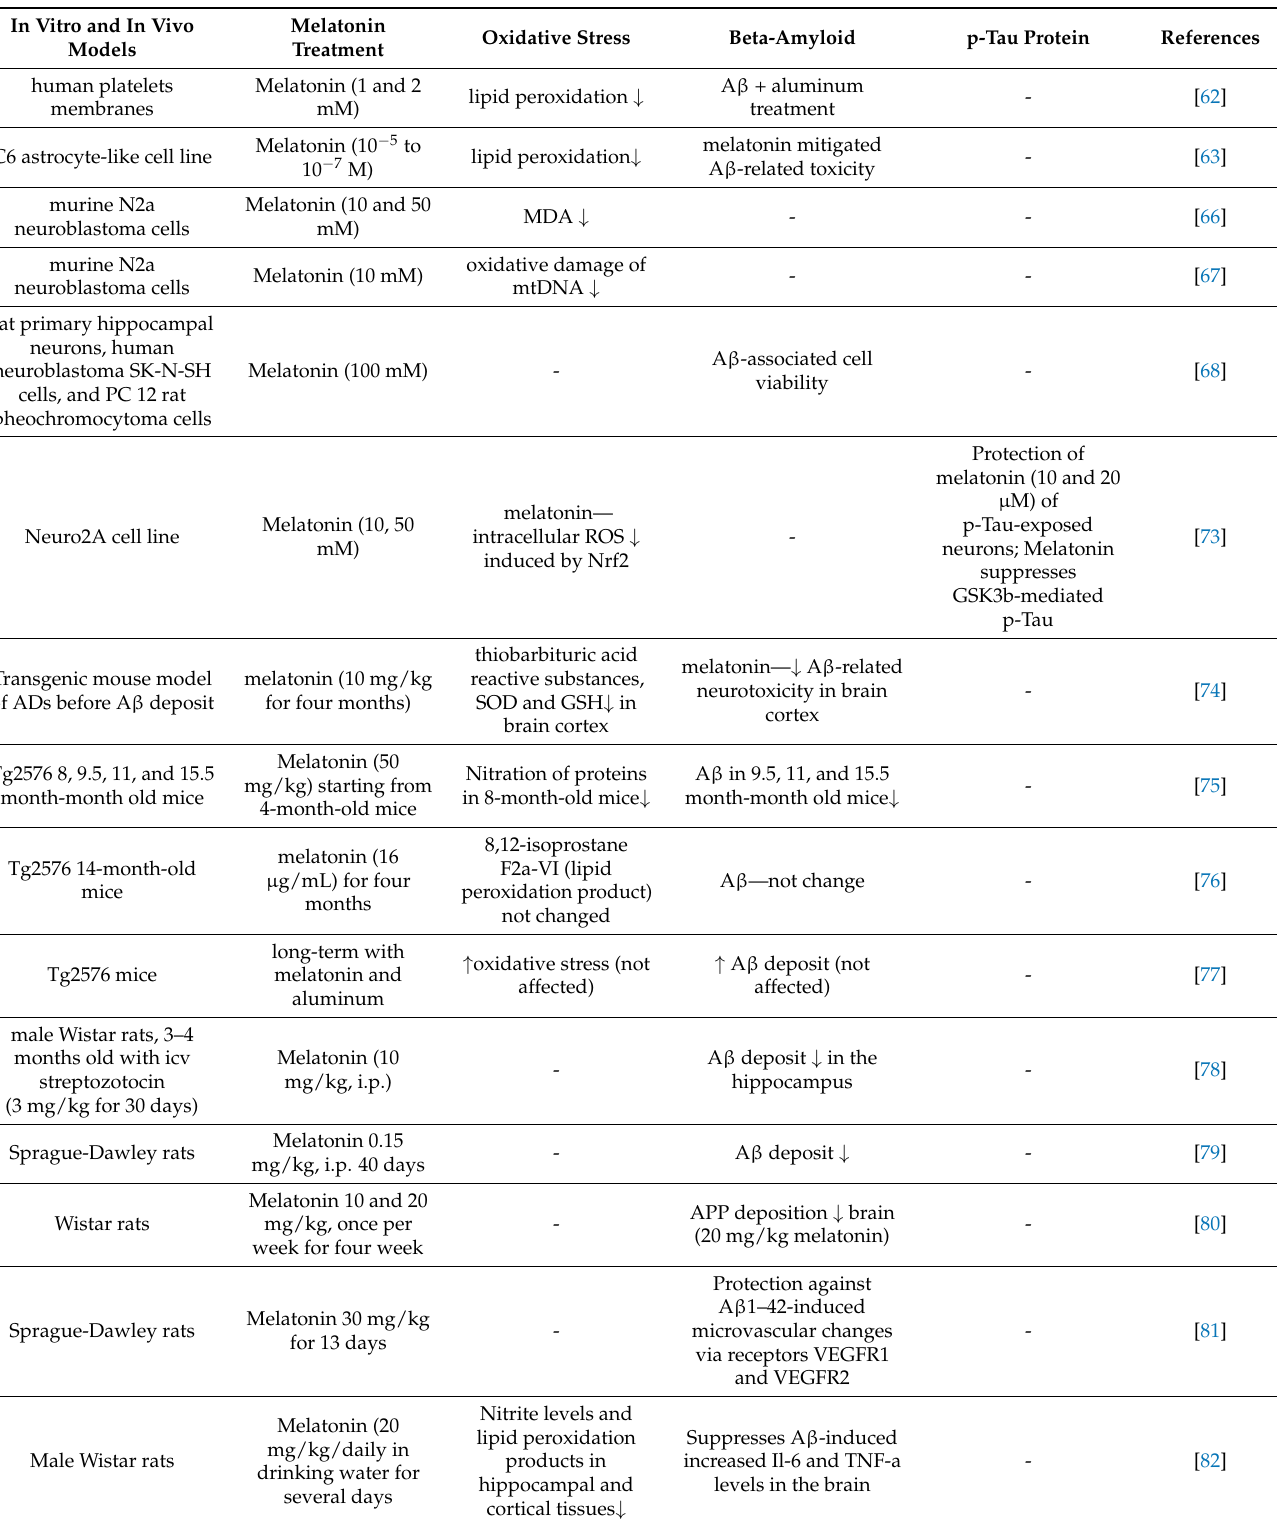
Table 3. The antioxidant role of melatonin in the pathogenesis of AD and aging (animal data and